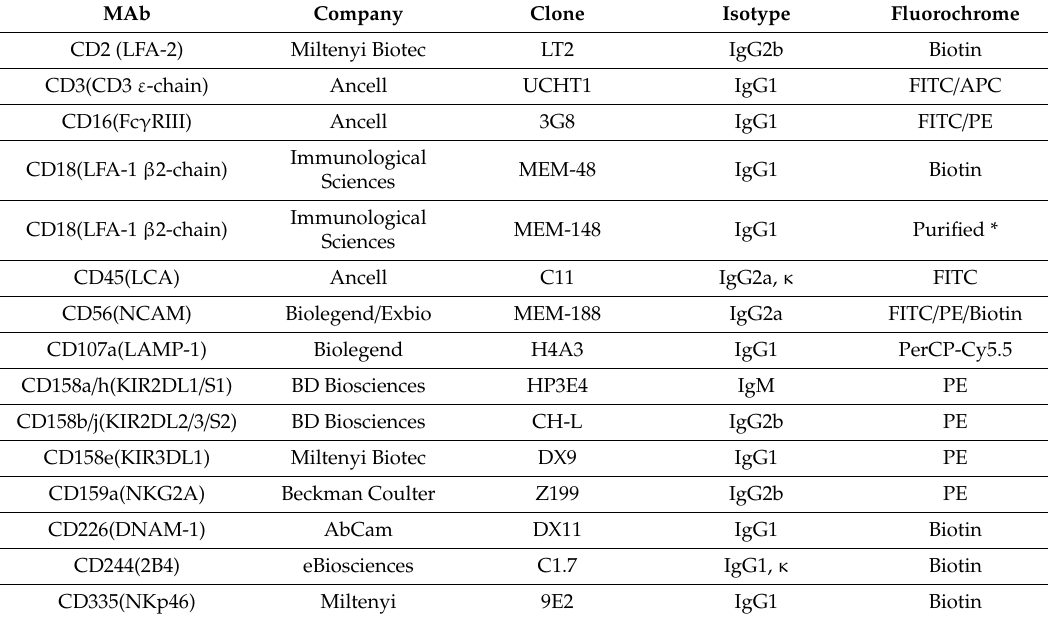
Table 1. Antibody